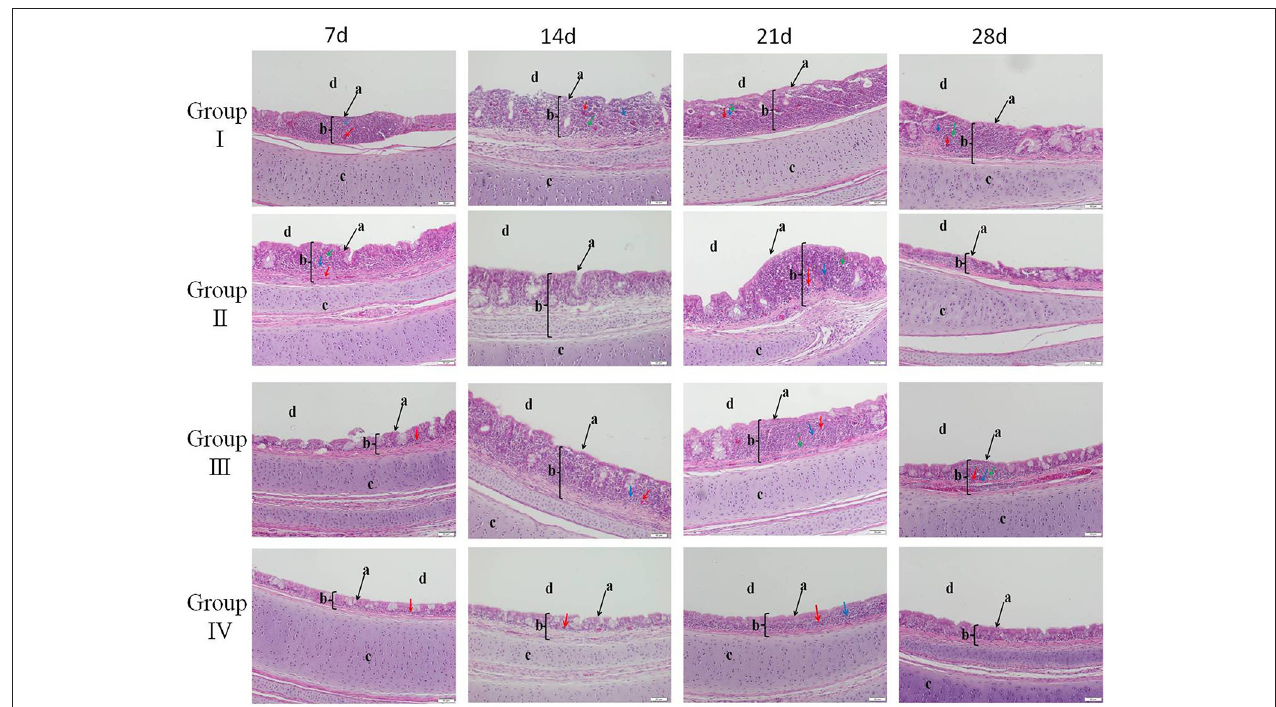
FIGURE 4 | HE staining to delineate the relieving effect of SGDL granule combined with doxycycline on IBV-induced trachea histopathogic changes (magnification, × 200). Group I served as a control. Broilers in Group II were given doxycycline whereas Group III was given SGDL granule through drinking water. Broilers in Group IV were given SGDL granule and doxycycline in drinking water. It was intraocularly and intranasally challenged by IBV at day 28. a indicates cilia; b indicates trachea mucosa; c indicates trachea cartilage; and d indicates trachea lumen. Red arrow: congestion; blue arrow: lymphoid cell; green arrow: mononuclear cell. SGDL, Shegandilong; HE,